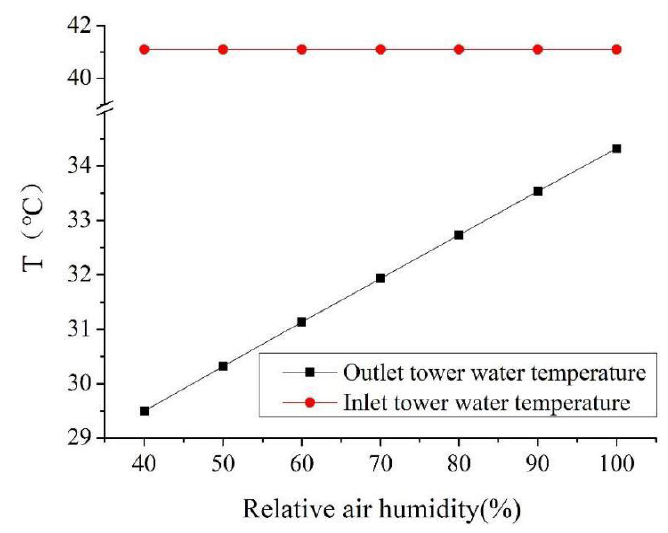
Figure 7. Outlet tower water temperature and relative air humidity.